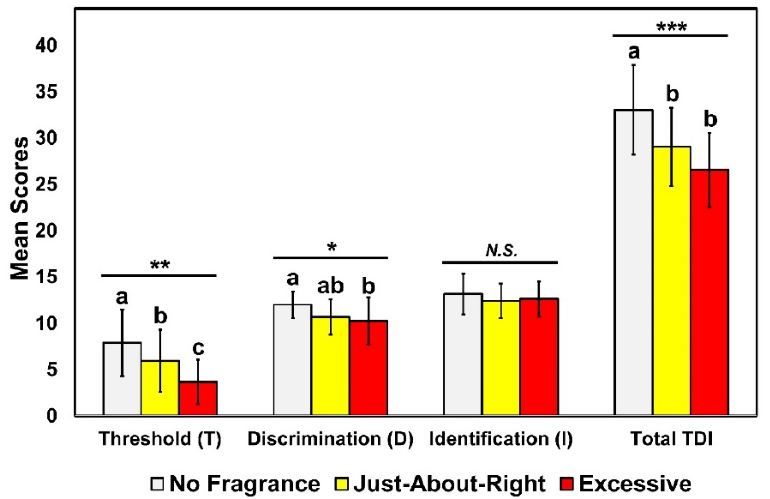
Figure 1. Mean score comparisons among the three fragrance conditions: no fragrance, just about right (JAR) fragrance, and excessive fragrance, with respect to the odor threshold (T), odor discrimination (D), and odor identification (I) tasks, along with a combined TDI score, for the Sniffin’ Sticks test. Error bars represent standard deviations. *, **, and *** represent a significant difference at p < 0.05, p < 0.01, and p < 0.001, respectively. N.S. represents no significant difference at p < 0.05. The different letters above the bars within each olfactory task category indicate a significant difference at p <